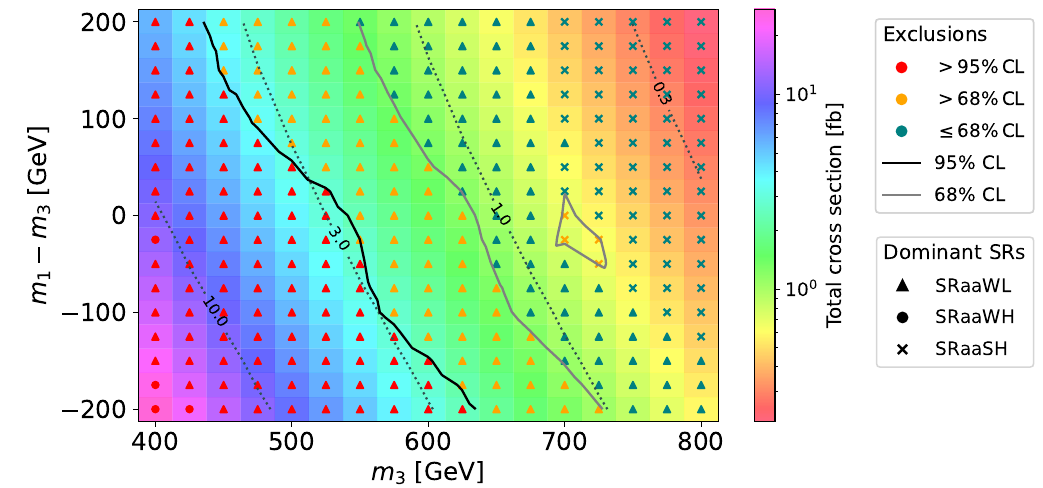
Figure 9. Bounds on the pNGB masses for the Drell-Yan production of the custodial triplet η 3 and singlet η with the quintuplet η decoupled (scenario S-31). Depending on the mass hierarchy, 1 5 the pNGBs decay either into di-bosons or into one vector boson and a lighter pNGB. The heatmap and the dotted contours show the total cross section. The bounds are obtained from ref. [70], with the dominant signal region indicated by the marker symbol (see appendix A.3 for details.). The 95% and 68% CL exclusion contours are drawn in solid black and gray,